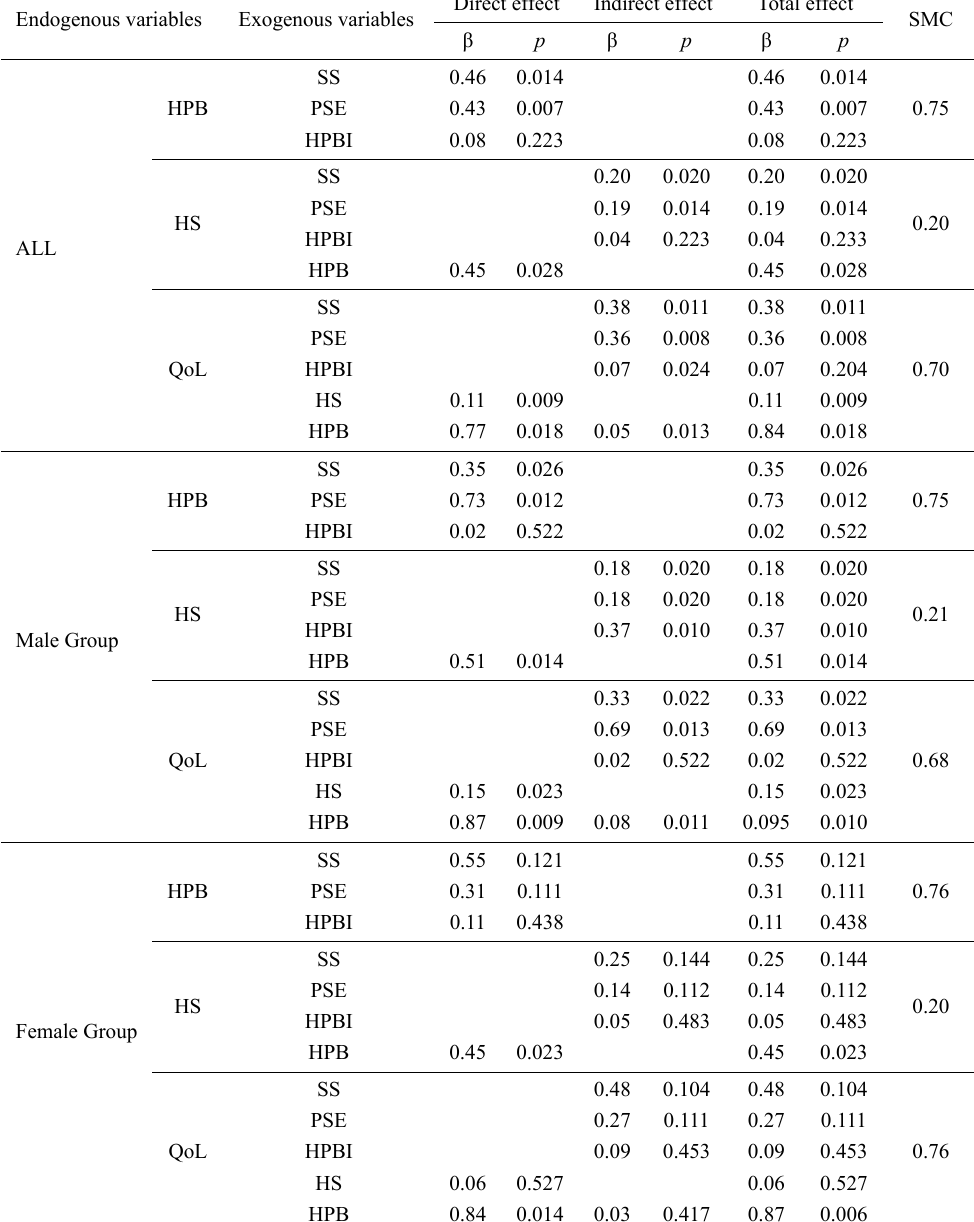
Table 3. Standardized direct, indirect, and total effects of the modified